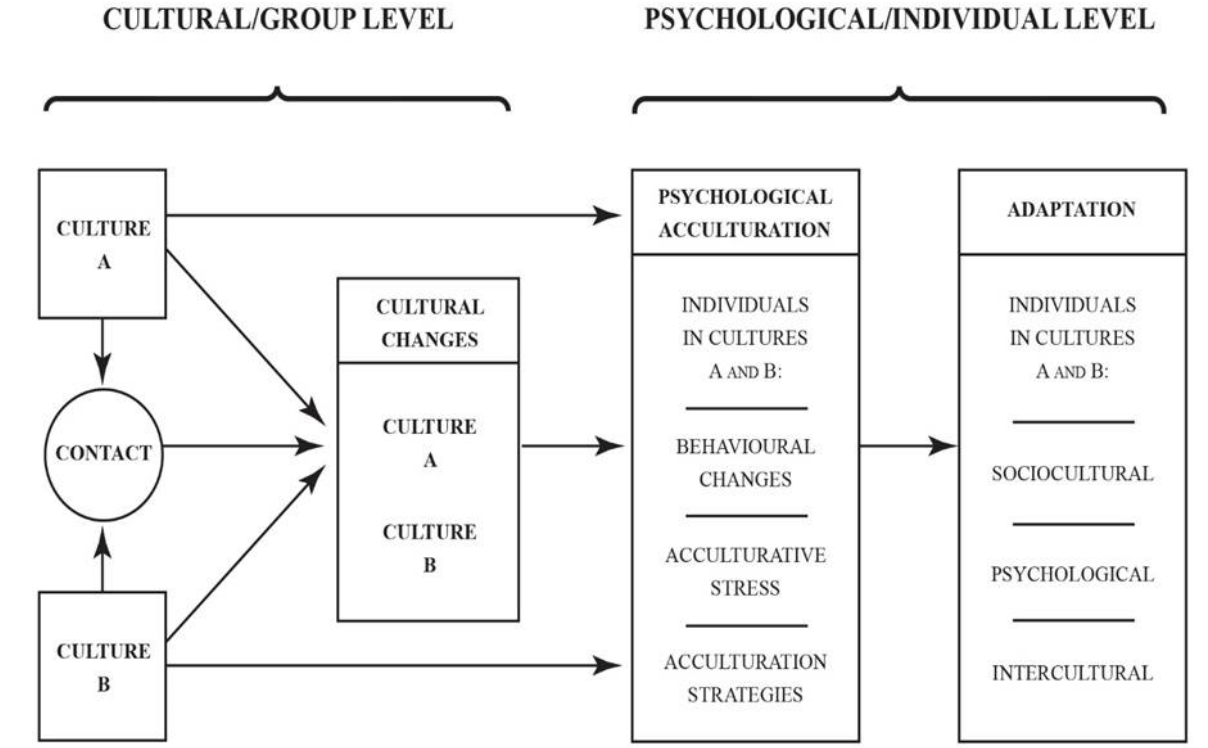
Figure 2. F ramework for Examining Acculturation and Adaptation of Groups and Individuals. Figure 2. Framework for Examining Acculturation and Adaptation of Groups and Individuals